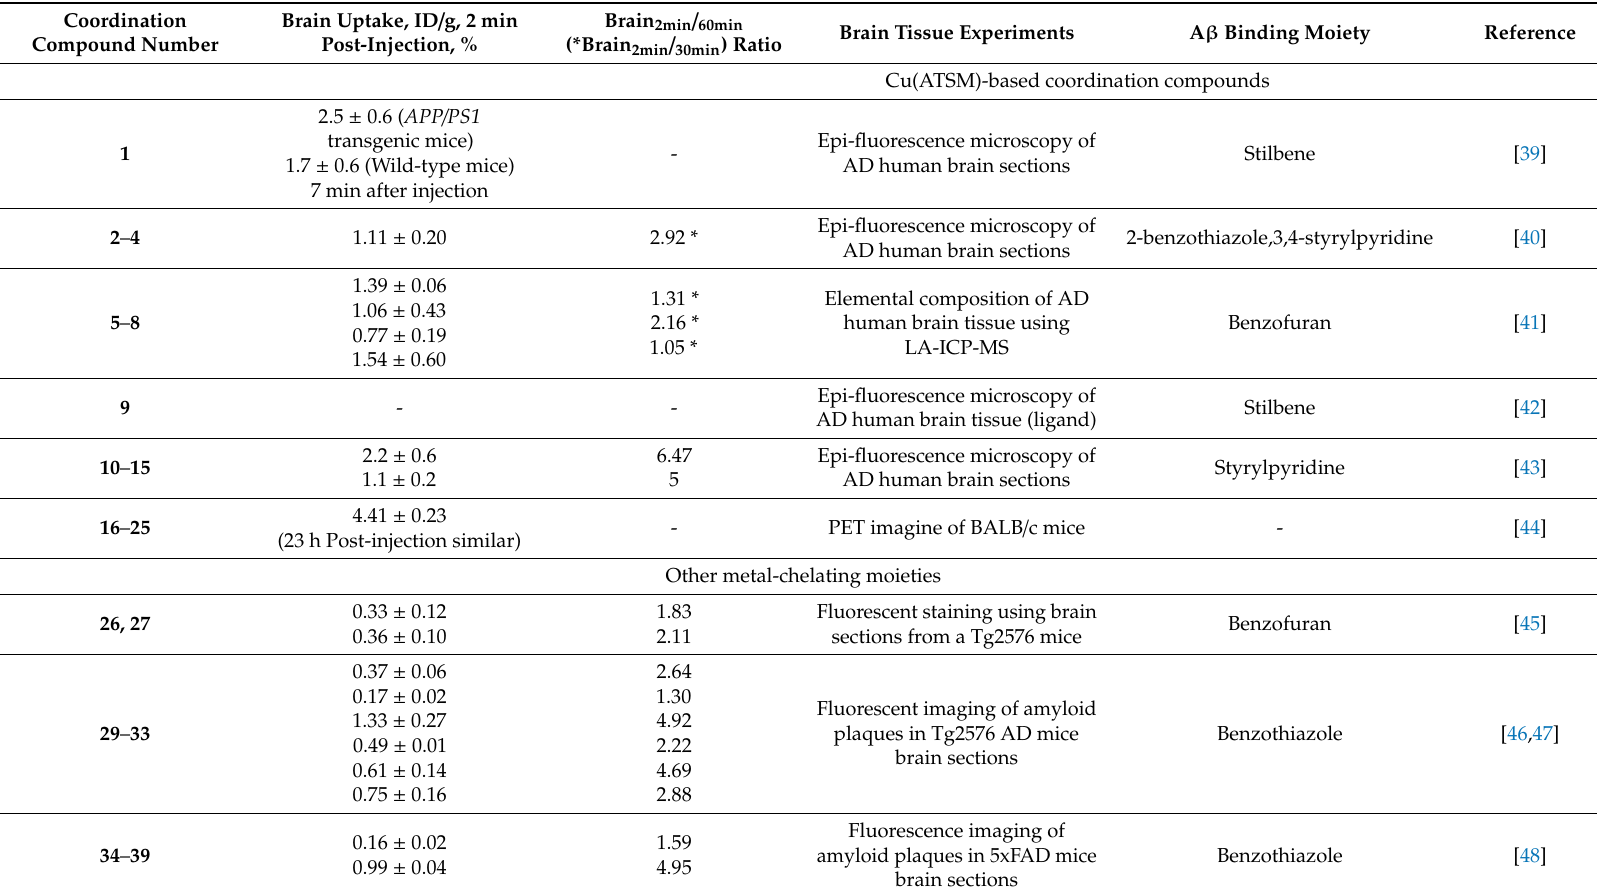
Table 1. Cu(II)-based coordination compounds for positron emission tomography (PET) imagining of Alzheimer disease. Coordination Compound